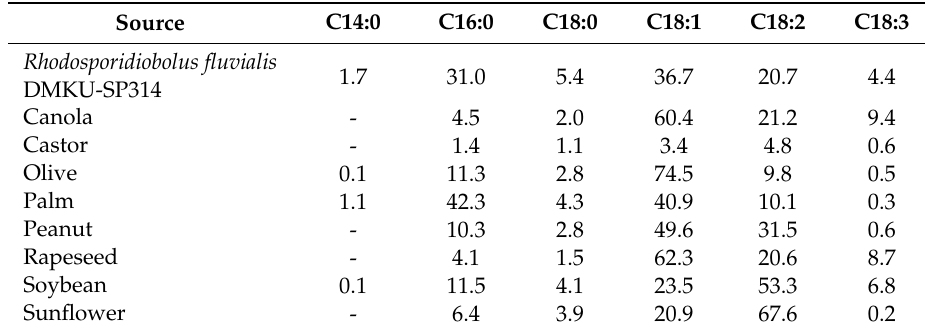
Table 7. The fatty acids composition (%) produced by R. fluvialis DMKU-SP314 when grown on STH and its comparison with other plant